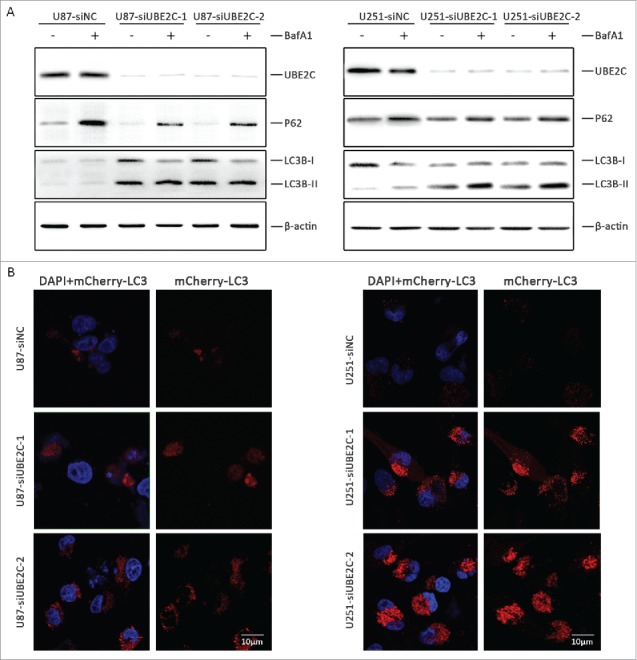
Autophagy induction by UBE2C attenuation. (A) U87-MG and U251 cells were transiently transfected with or without si-UBE2C for 48 h. Next, both cell lines were treated with the indicated concentrations of BafA1 along with the vehicle control; then, the expression of UBE2C, SQSTM1/p62 and LC3B-I/II was determined by Western blot. β-Actin was used as a loading control. (B) U87-MG and U251 cells were first transiently transfected with or without si-UBE2C for 48 h and were further transfected with an mCherry-LC3 vector for another 24 h. Next, autophagosomes were measured by confocal microscopy. Each image is a representation of 3 independent experiments performed in triplicate.